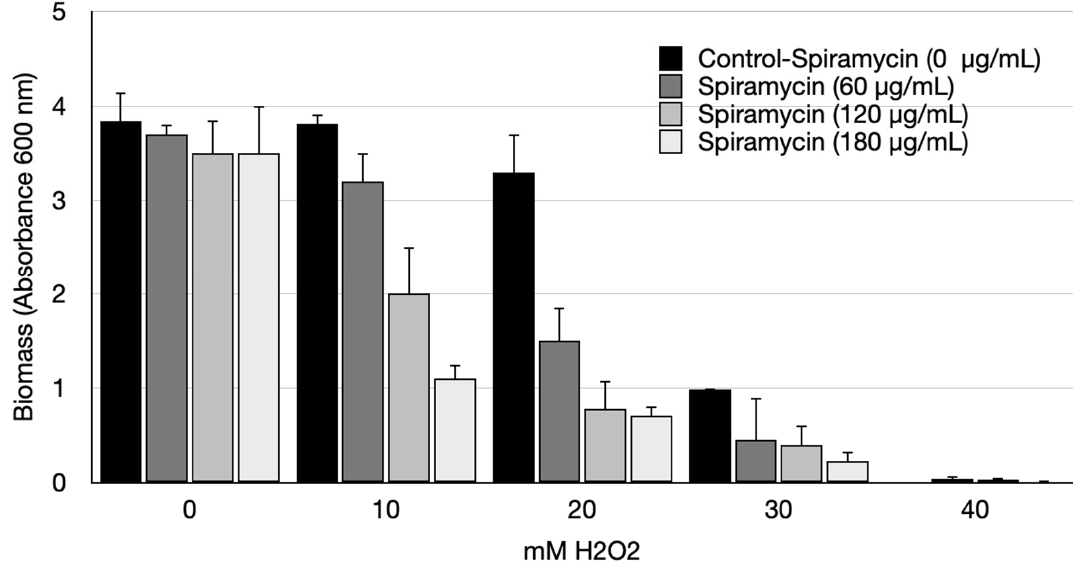
Figure 5. Growth of P. aeruginosa with hydrogen peroxide (H 2 O 2 ) with or without spiramycin. The control value is indicated by a dotted line. Growth was carried out in LB at 37 °C and 180 rpm.